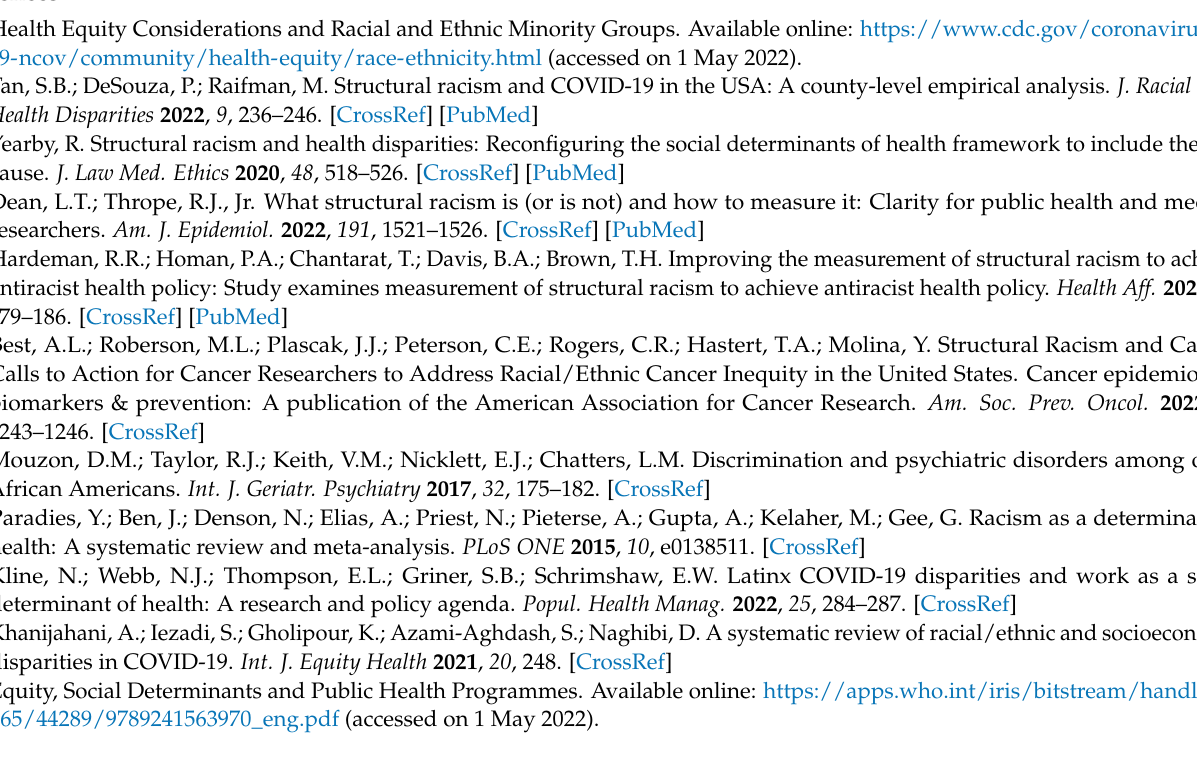
Figure A3. Distribution of COVID-19 Cumulative Infection Rates (per 100k) by New Jersey munici- palities characterized by Relatively High Percentages of Black Residents (RHB-red) and Relatively Low Percentages of Black Residents (RLB-blue) during Wave 1 ( A ), Wave 2 ( B ), and Wave 3 ( C ). Notes: The vertical lines represent the mean infection rate in RHB (red) and RLB (blue) municipalities; so, the horizontal distance between the two vertical lines visualizes the gap for each wave. In this figure, the red bars (RHB municipalities) are shifted consistently to the right of the blue bars (RLB municipalities) in Waves 1 and 2.